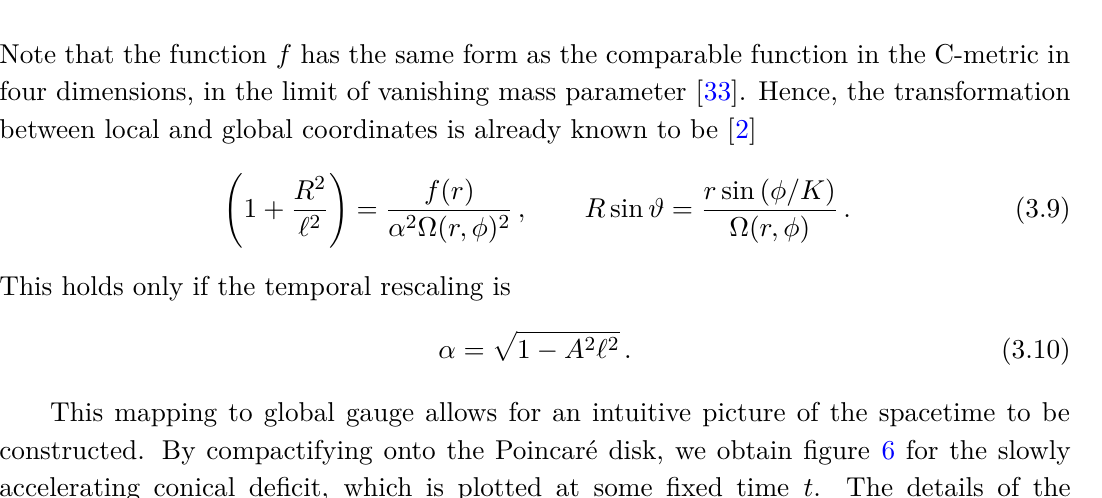
Figure 5 . The two patches of type I spacetime used to construct a slowly accelerating conical defect. Left : point particle pulled by a domain wall. Right : point particle pushed by a